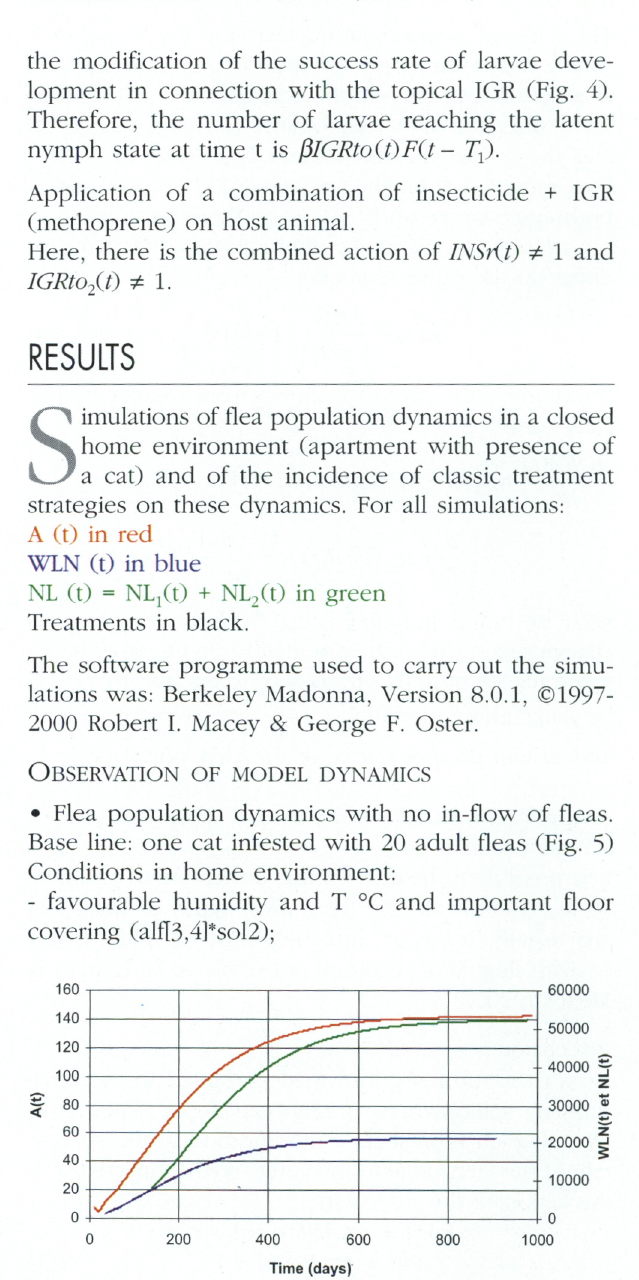
Fig. 3. - INSr(t) as a function of time for a treatment of cats carried out at t = 10 d. The figure 0 corresponds to 100 % mortality, and 1 to the maximum number of adult fleas (100 % viable).